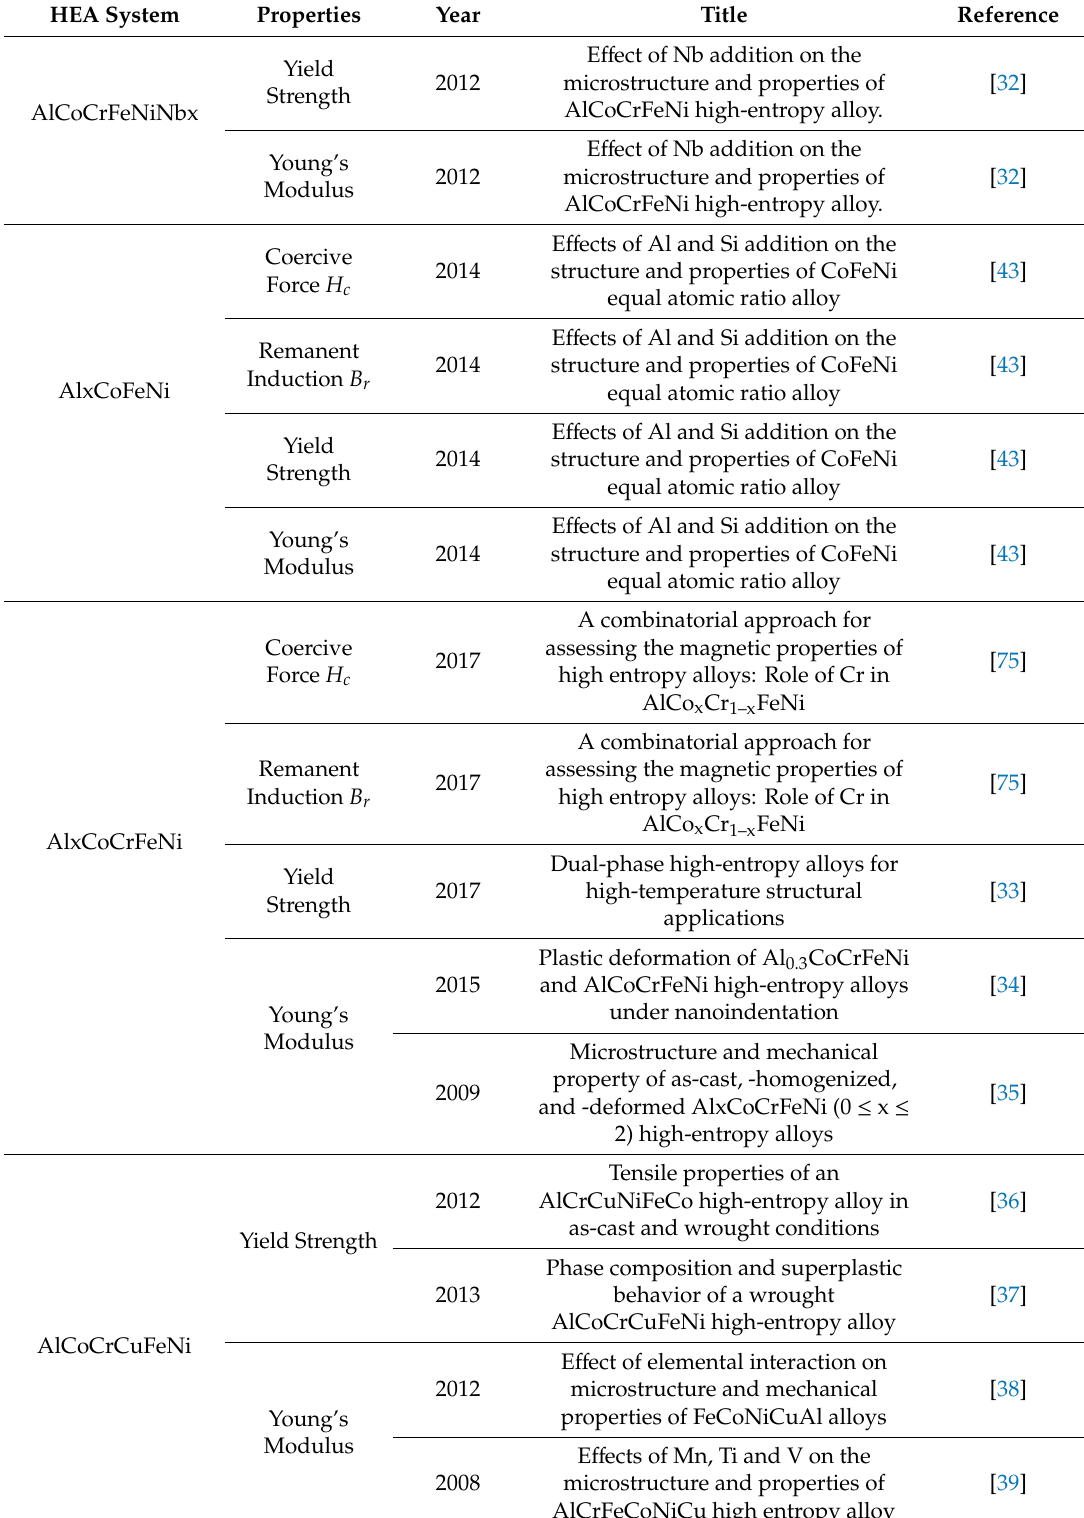
Table 2. Summary of high-entropy alloys (HEAs) and complex concentrated alloys (CCAs) for magnetic